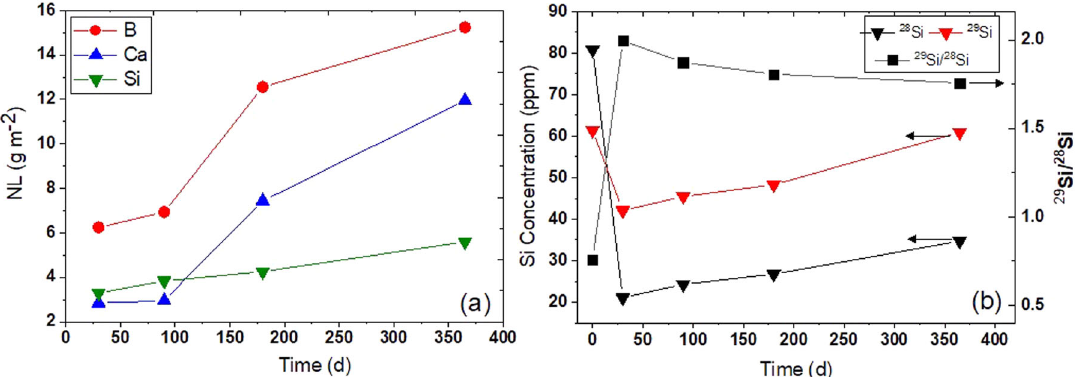
Fig. 7 Solution analyses data from ISG( + SS) dissolution in silica-saturated NaCl. a NL for B, Si and Ca. b The concentrations of 28 Si and 29 Si measured by ICP-MS and the 29 Si/ 28 Si isotopic ratio in the bulk solution. The contact area between ISG and SS and ISG and PTFE has been included for these